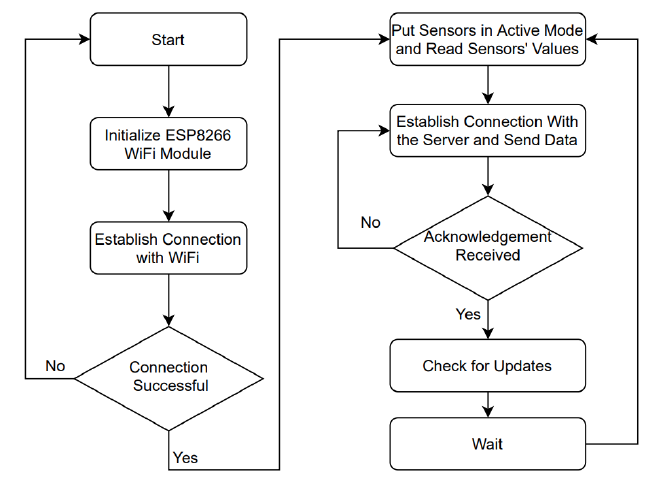
Figure 6. Flowchart of Dustbox 2.0